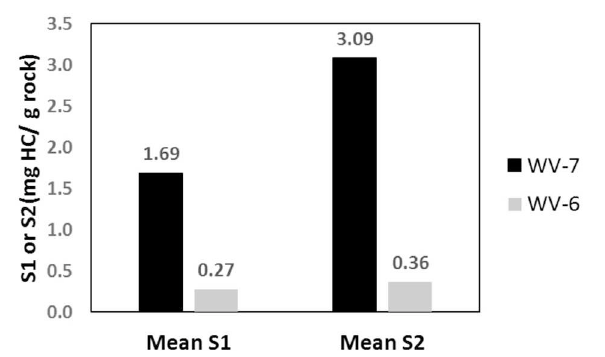
FIGURE 2 | Average S1 and S2 values of WV-6 and WV-7 shale